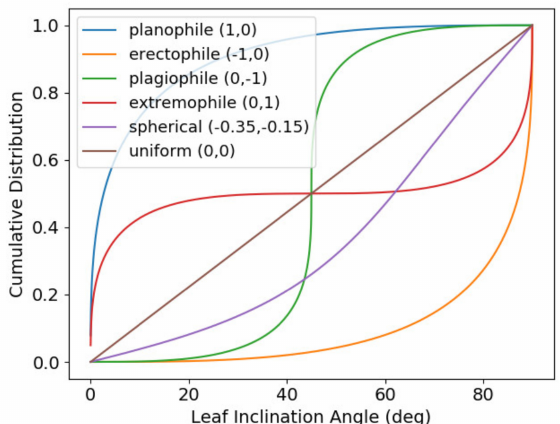
Figure 7. Leaf angle distribution (LAD) cdfs of some of the more prominent named distributions. Each distribution is defined here by its name, e.g., planophile, and its two variables ( a , b ) according to the method described by Verhoef